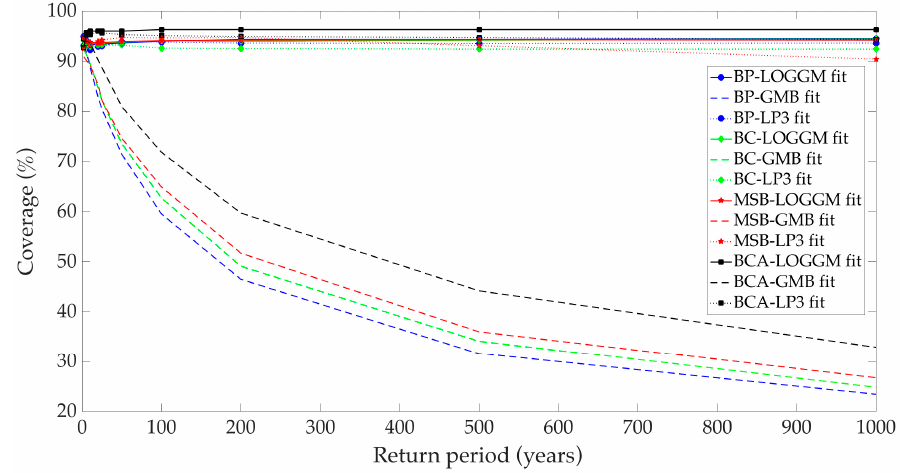
Figure 7. Coverages for the Apazulco station (14011) for a LOGGM mother distribution.